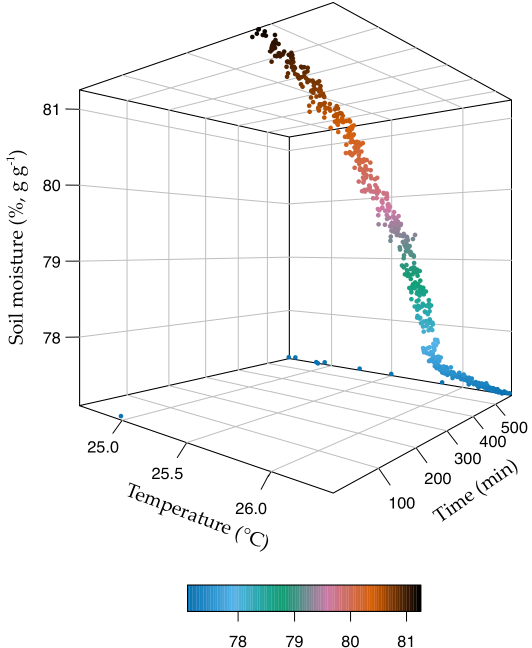
Figure 5. Soil moisture loss with time. The developed calibration function (gravimetric basis) was used to derive the soil moisture loss every minute (Equation